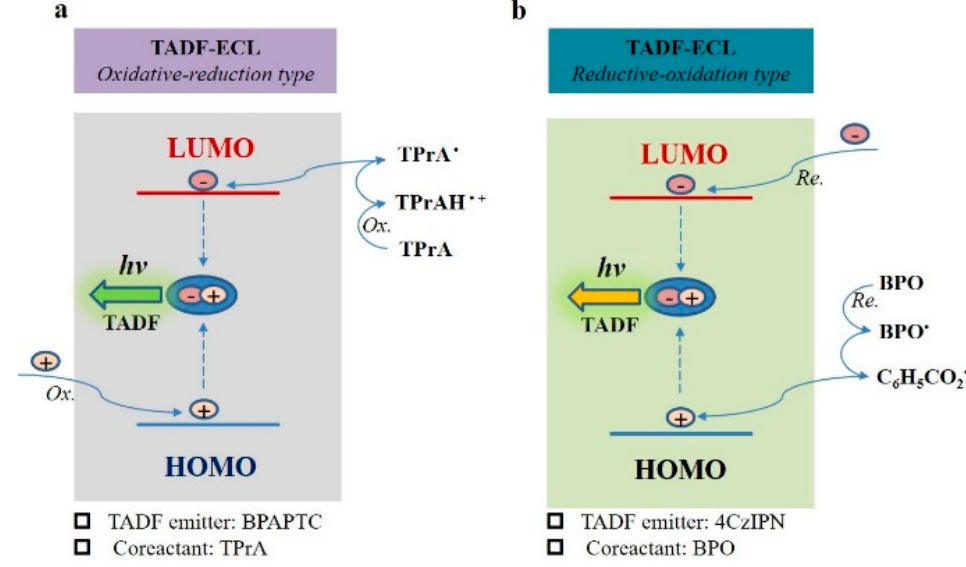
Figure 7. The proposed mechanisms of oxidative–reduction TADF-ECL using BPAPTC/TPrA cou- ( a ) and reductive–oxidation TADF-ECL using 4CzIPN/BPO couple ( b ple ( a ) and reductive–oxidation TADF-ECL using 4CzIPN/BPO couple ( b ).